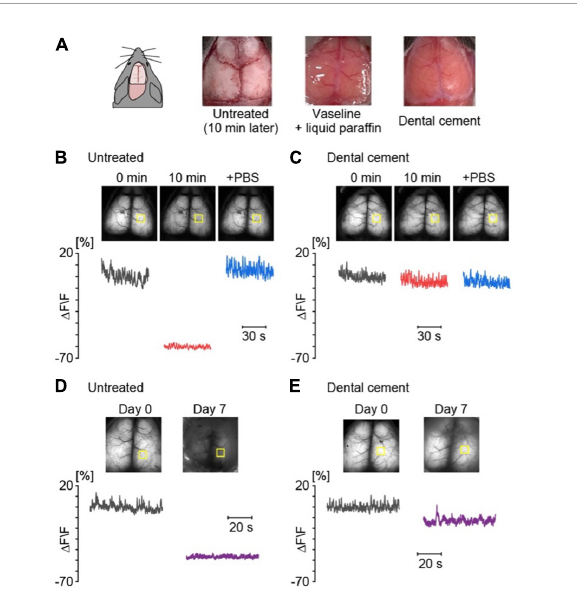
FIGURE2 The skull treatment is necessary to obtain high-quality data for a long-term observation. (A) Examples of the skull surface without treatment and with Vaseline + liquid paraffine or dental cement. (B) Examples of cortical spontaneous activities for 1 min in an anesthetized G7NG817 mouse without treatment; just after removal of connective tissue (black), 10 min later (red), and after application of PBS to the dried skull surface (blue). The yellow squares indicate the region of interest (ROI) of the cortical region for the calculation of the fluorescence change ratios ( (cid:49) F/F). Each F value was calculated from the mean of 0 min. (C) Examples of cortical activities with application of dental cement on the skull surface, 0 min (black), 10 min (red), + phosphate-buffered saline (PBS) (blue), respectively. (D) Examples of cortical spontaneous activities for 1 min without treatment on day 0 (black) and day 7 (purple). (E) Examples of cortical spontaneous activities for 1 min with dental cement on day 0 (black) and day 7